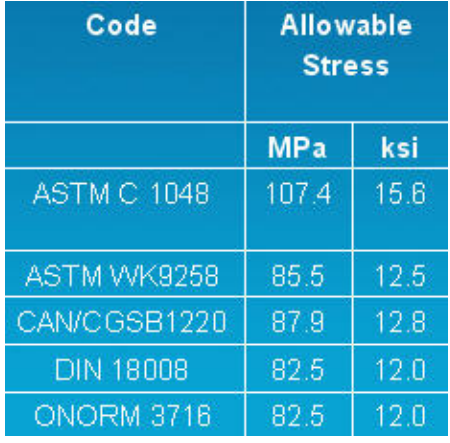
Figure 8: Allowable stresses determined vs. five different glass design guidelines for a post- breakage condition.